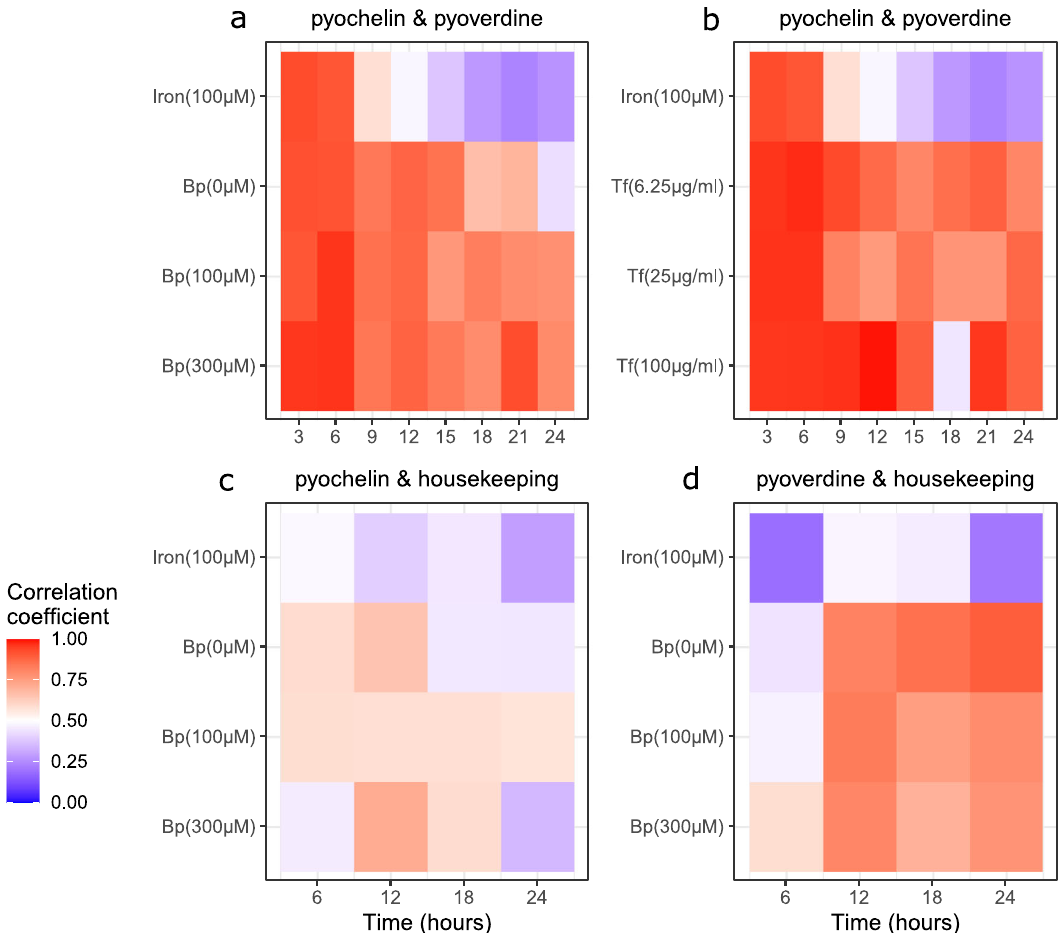
Fig. 5 Correlations between pyochelin, pyoverdine, and housekeeping gene expression among clonal cells across time and media. Correlation coef fi cients are shown as heatmaps, and indicate the strength of associations in the expression of two genes across individual cells within a population. a , b Correlations between pyochelin ( pchEF ) and pyoverdine ( pvdA ) gene expression, measured with the double reporter strain PAO1 pvdA :: mcherry – pchEF :: egfp in iron-supplemented CAA medium and in CAA media supplemented with either increasing concentrations of the iron chelators bipyridyl or apo-transferrin. c Correlations between pyochelin pchEF and housekeeping rpsL gene expression, measured with the double reporter PAO1 pchEF :: mcherry – rpsL :: egfp in iron- supplemented CAA medium and in CAA media supplemented with increasing concentrations of the iron chelator bipyridyl. d Correlations between pyoverdine pvdA and housekeeping rpsL gene expression measured with the double reporter PAO1 pvdA :: mcherry – rpsL :: egfp in iron-supplemented CAA medium and in CAA media supplemented with increasing concentrations of the iron chelator